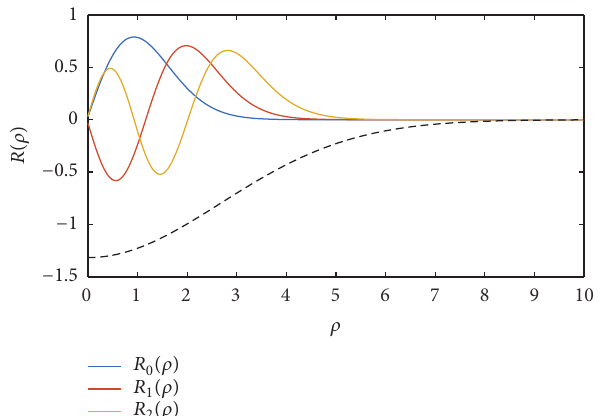
(𝜌) of three lowest 𝜌